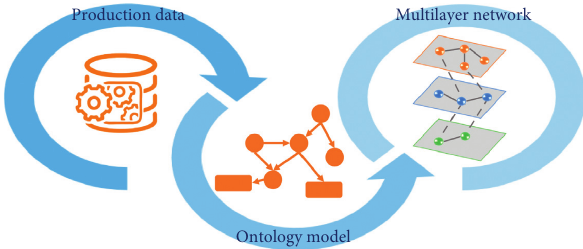
Figure 11: The steps of data transformation toward creating a process-specific ontology and multilayer